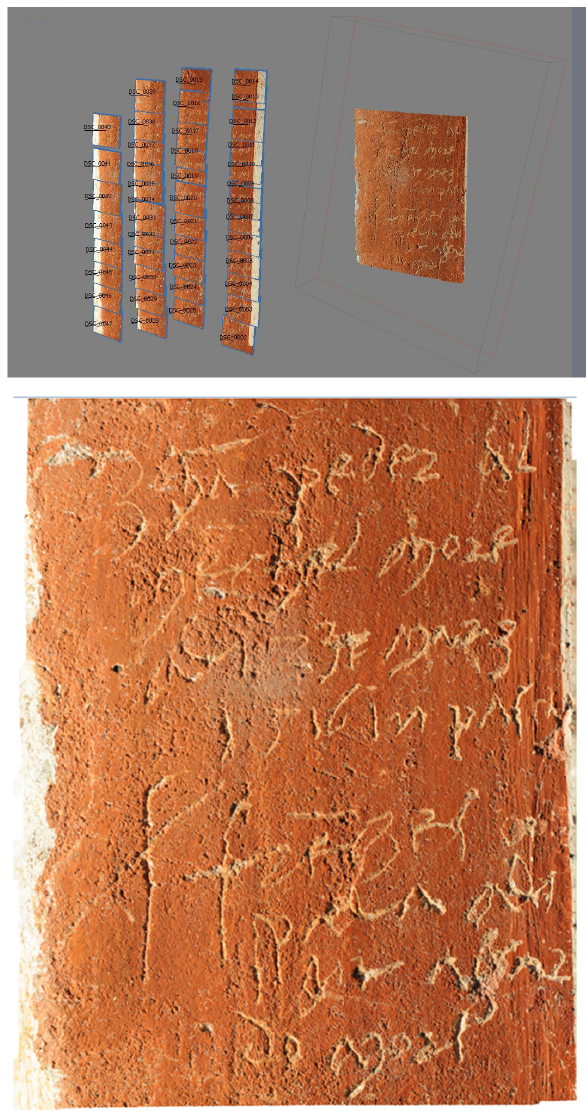
Figure 4. Macro image set (above) and resulting orthophoto (below)